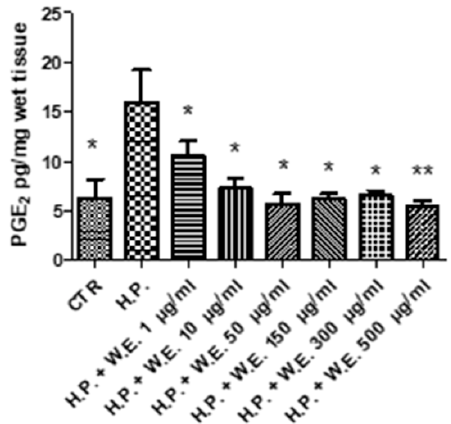
Figure 7. Inhibitory effect induced by Futura 75 water extract (W.E.) on L-dopa turnover increased by hydrogen peroxide (H.P.) 1 mM in isolated mouse skin specimens. ANOVA, P<0.01; *P<0.05 vs. H.P.